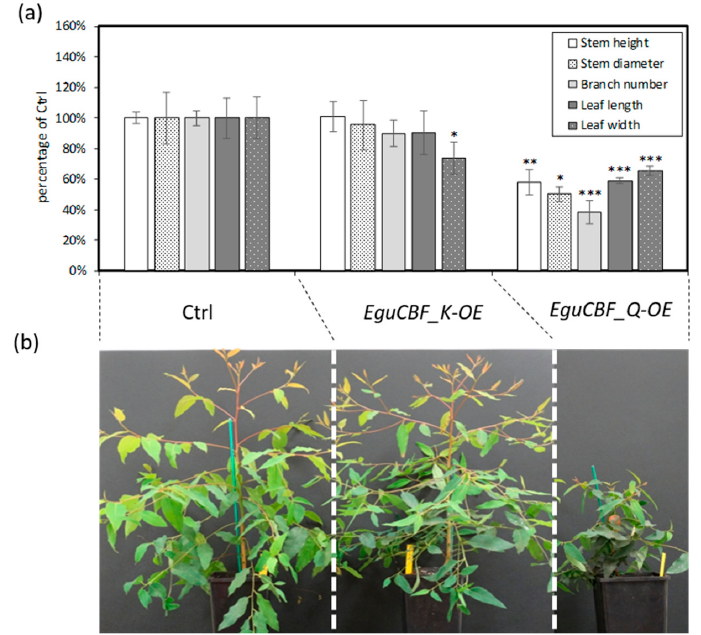
Figure 2. Comparison of morphological parameters between CBF -OE and control lines. ( a ) Morphological traits (stem height, stem diameter, branch number, leaf length, and width) were measured on 6-month-old CBF -OE ( EguCBF_K -OE, EguCBF_Q -OE) and control plants (Ctrl). The results are means ± SD of six biological replicates. Statistical difference with control was assessed using Tukey HSD test: *** ( p < 0.001), ** ( p < 0.01), and * ( p < 0.05). ( b ) General shape and size of 6-month-old plants.